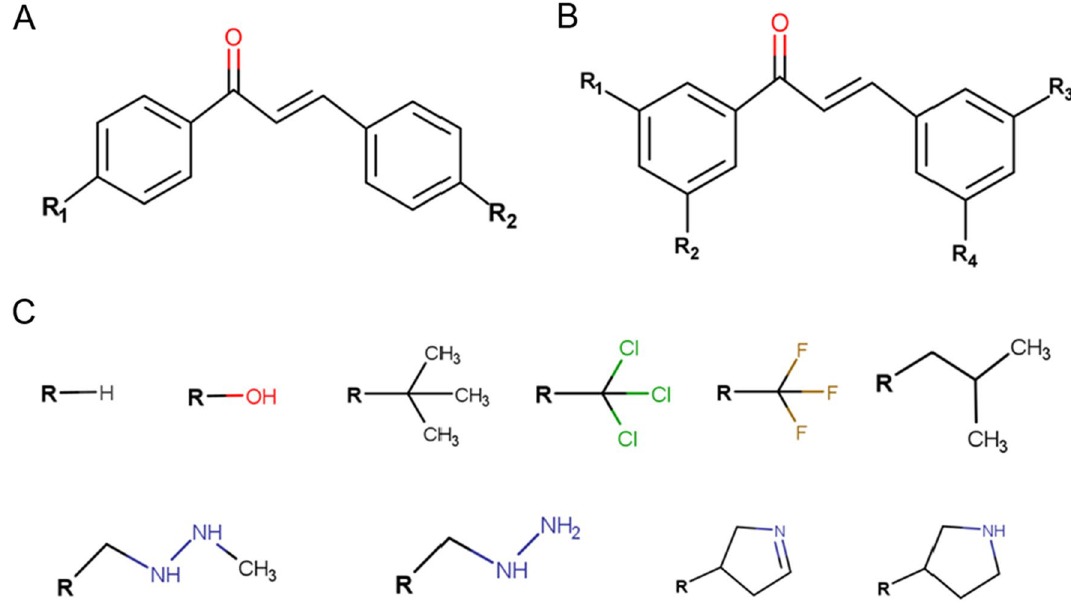
Fig. 5 Developmental components of chalcone derivatives. A Substitution of chalcone in para sites of benzene rings. B Substitution in meta sites. C Substituents used in both substitution schemes. Images generated using